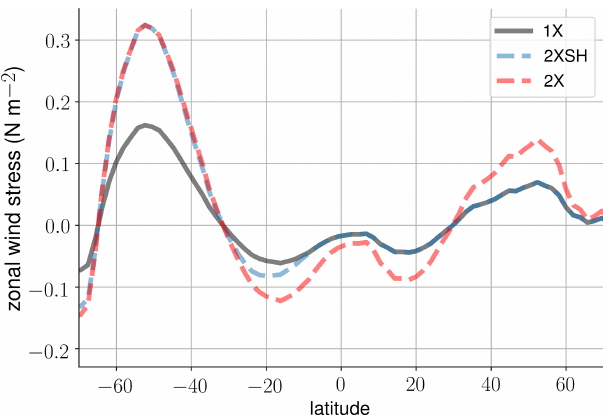
Figure 1. The zonal-mean zonal wind stress in the 1X experiment (black), 2XSH experiment (blue), and 2X experiment (red) (from Lüschow et al.,